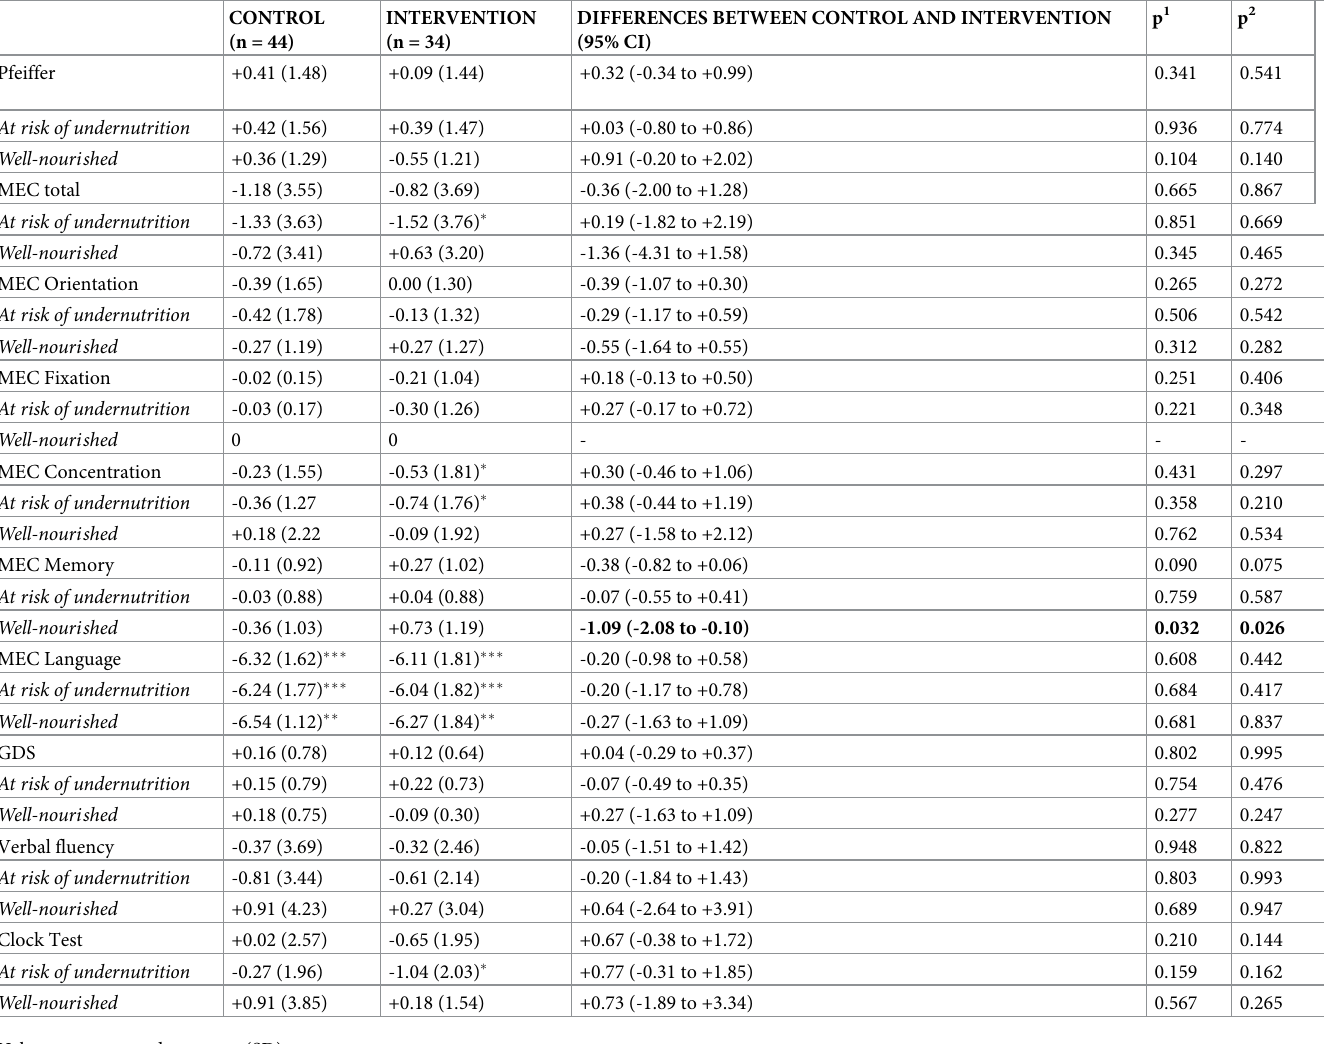
Table 3. Mean differences of cognitive scales after 1 year of follow-up between control and intervention group and stratified by nutritional